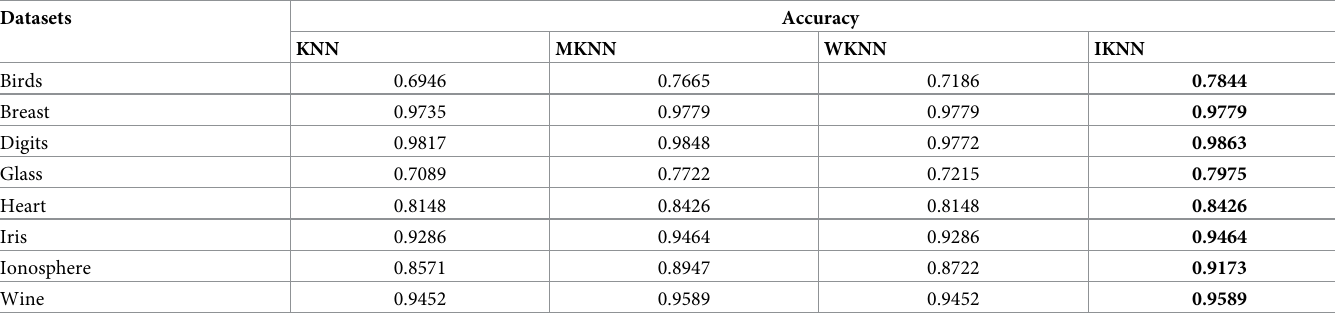
Table 7. The comparison of classification accuracy of different strategies. Datasets